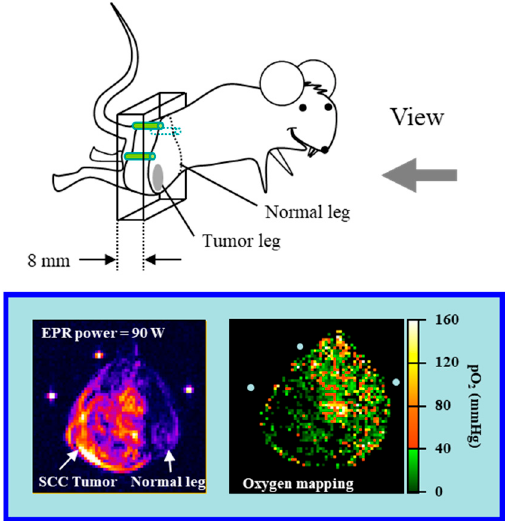
Figure 7. An examples of DNP basis in vivo oxygen mapping. Top: The direction of the slice view of OMRI image with respect to the subjected mouse. Bottom left: Spin-density image (raw OMRI image) shows the differential accumulation of the paramagnetic oxygen probe, Oxo63. Bottom right: Oxygen mapping of an axial slice of the tumor-bearing and normal legs of a mouse computed from OMRI images taken at two different EPR power levels. The figures were partly modified from our previous reports [78].